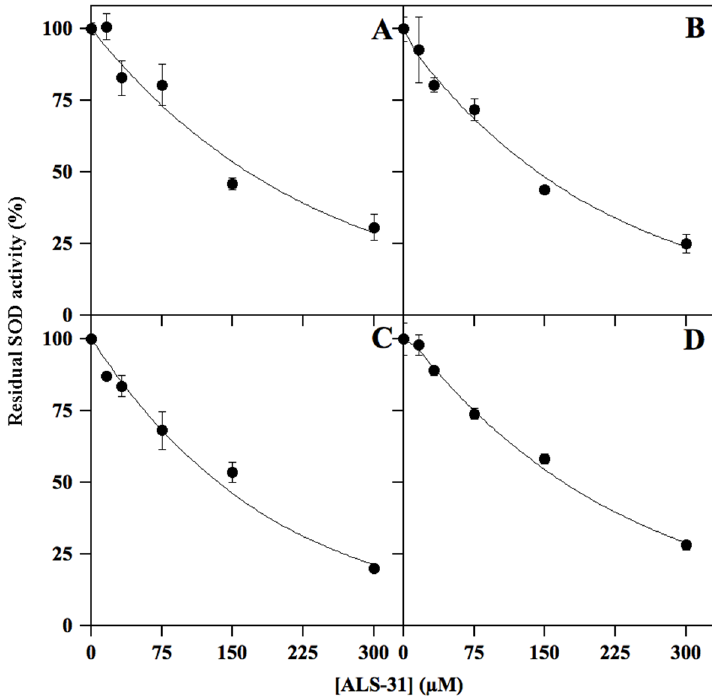
Figure 5. Representative effect of ALS-31 on the activity of different SODs. The activity of St SOD ( A ), Fe-SOD from Escherichia coli ( B ), Mn–SOD from rat mitochondria ( C ) or Cu/ZnSOD from bovine erythrocytes ( D ) was measured and expressed ( ) as indicated in Figure 3. •